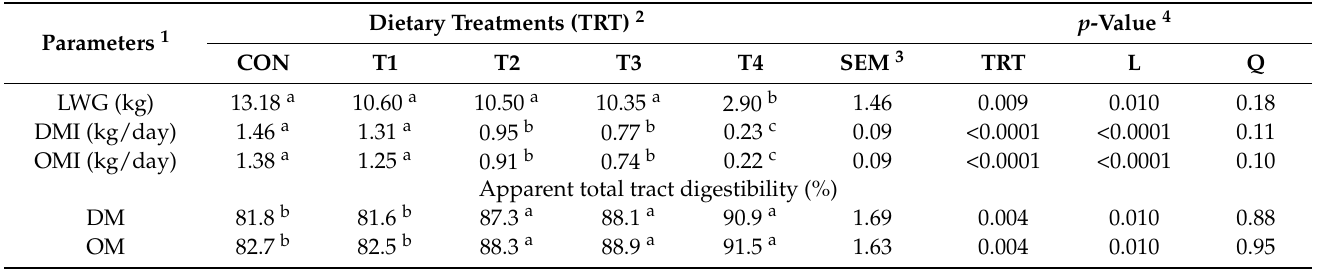
Table 3. Effect of dietary treatments on growth performance and apparent total tract digestibility in growing lambs from 1 to 75 days during the study period.